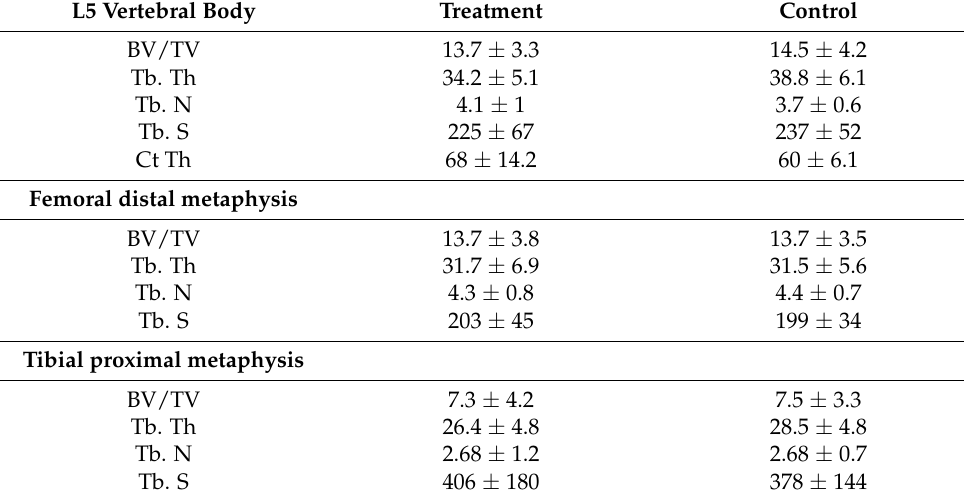
Figure 4. Micrographs of representative histological transverse sections of L5 vertebral body ( A , B ), femoral distal metaphysis ( C , D ), and tibial proximal metaphysis ( E , F ) of treatment and control groups. Table 2. Histomorphometric parameters measured in L5 vertebral body, femoral distal metaphysis, and tibial proximal metaphysis sections. BV/TV: trabecular bone volume (%); Tb.Th: trabecular thickness (µm); Tb.N: trabecular number; Tb.Sp: trabecular separation (µm); Ct.Th: cortical bone thickness (µm). All values are expressed as mean ± S.D. (n = 7 for each group).